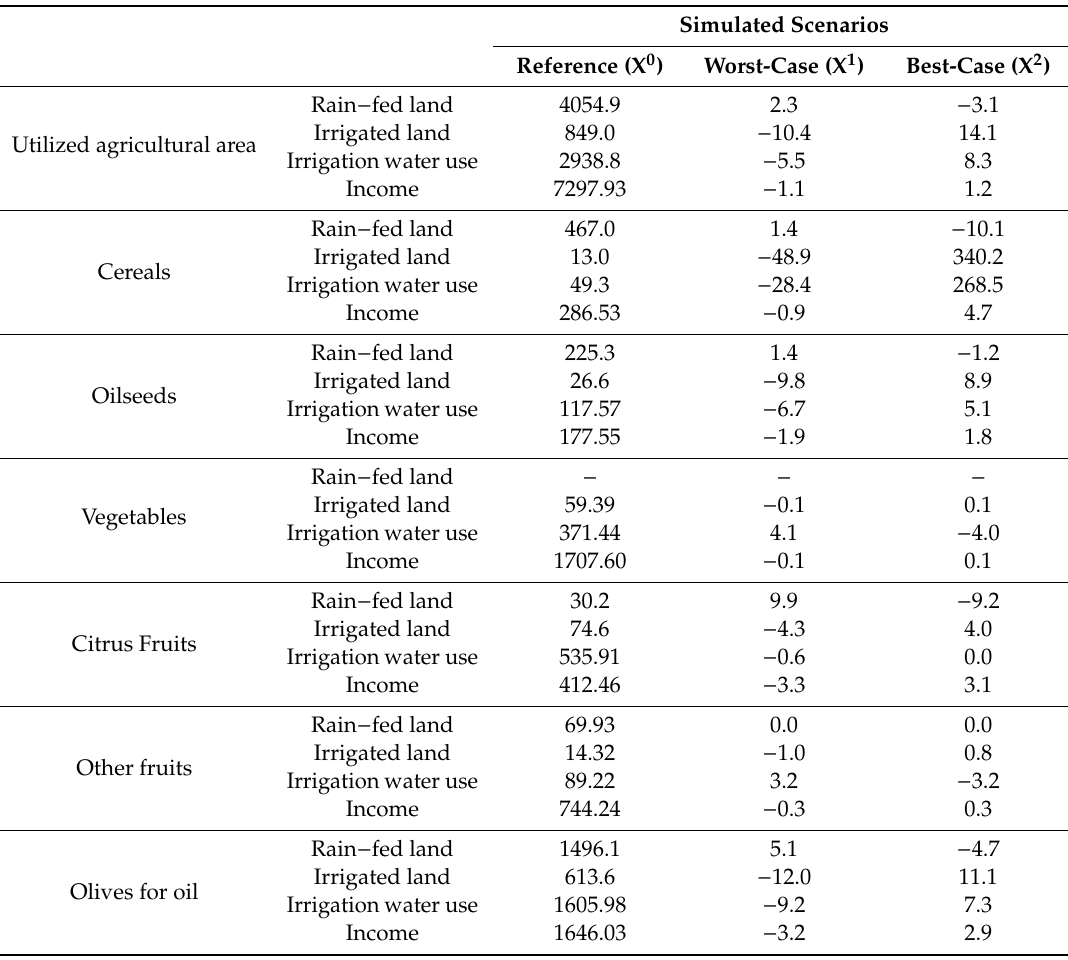
Table 2. Results from the reference, worst-case and best-case scenarios for rain-fed land, irrigated land, irrigation water use and income for main crops in Andalusia in 2050. The values are presented in absolute terms for the reference scenario and percentage change from the reference for the worst and best case scenarios. The units are 1000 ha for land, million m 3 for water use, and million euro for